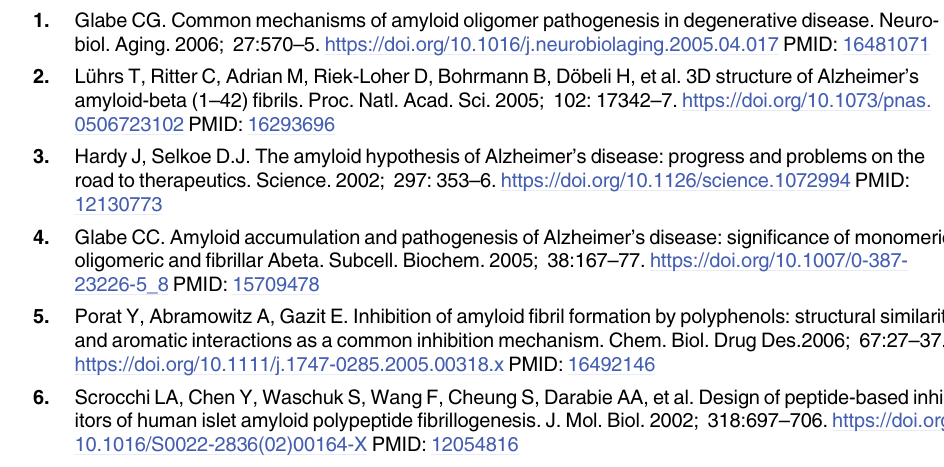
S1 File. Fig A. TEM images of rGOQDs acquired from different preparations. Fig B. UV − Vis absorption of 0.3 mg/ml of GOQDs and rGOQDs aqueous solutions. Fig C. AFM and 3D topographical images of GOQDs (A) and rGOQDs (B) and related line profiles (C) . (D) An enlarged view of GOQDs line profile. The arrows in (B) indicate some aggregates formed upon reduction. The scale bars represent 500 nm. Fig D. Congo red binding absorption spectra of bovine insulin in the absence and presence of various concentrations of GOQDs (A) and rGOQDs (B) . Congo red absorbance alone and in the presence of native bovine insulin are also indicated. Fig E. Line profiles of AFM images relating to Fig 4H, 4I and 4L. Fig F. Congo red binding absorption spectra of HEWL in the absence and presence of various concentra- tions of GOQDs (A) and rGOQDs (B) . Congo red absorbance alone and in the presence of native HEWL are also indicated. Fig G. Effect of various concentrations of GOQDs and rGOQDs on the viability of SH-SY5Y